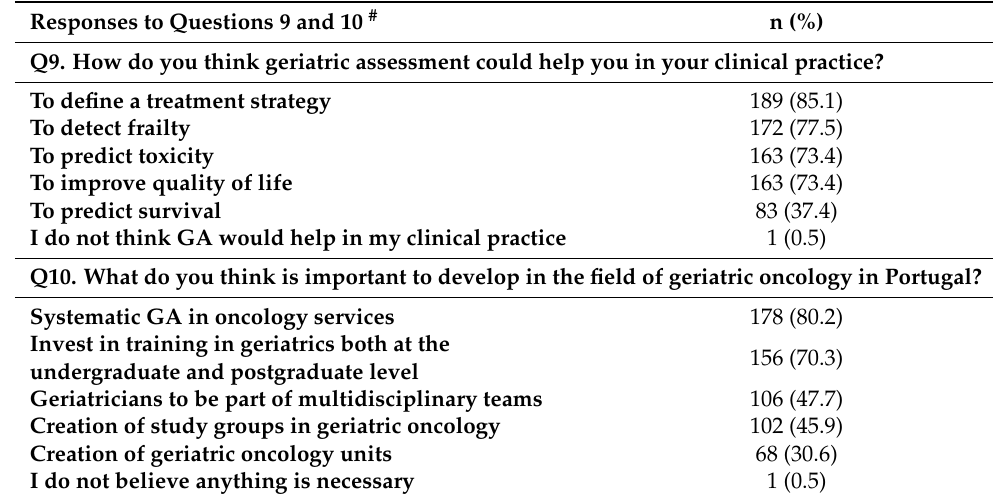
Figure 2. Geriatric assessment awareness and use of GA tools. ( A ) Reported use, in clinical practice, of GA/geriatric screening to evaluate elderly cancer patients (n = 222, values are expressed as percentages). ( B ) Geriatric assessment or screening tools used (n = 47 respondents, absolute values are reported). Abbreviations: G8 (Geriatric 8); CARG (Cancer and Aging Research Group); VES-13 (Vulnerable Elderly Survey-13); mRankin (modified Rankin) scale; others include: Timed Up and Go Test (TUG), Mini Mental State Examination, ePrognosis, Geriatric Depression Scale (GDS), Palliative Prognostic Index (PPI), Lawton–Brody Scale. Table 4. Advantages of geriatric assessment and potential areas for the development of geriatric